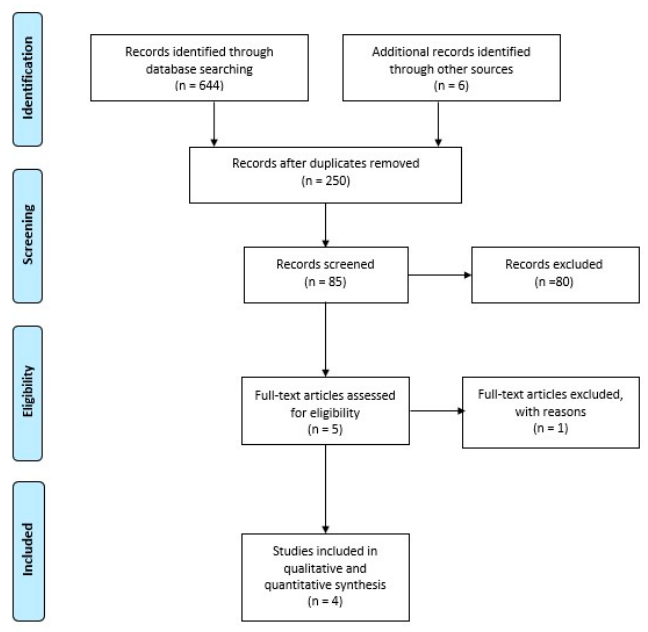
Figure 1. Preferred Reporting Items for Systematic Reviews and Meta-Analyses (PRISMA) 2009.